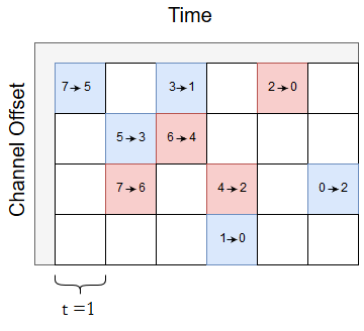
Figure 6. Scheduling a delay of τ = 1.